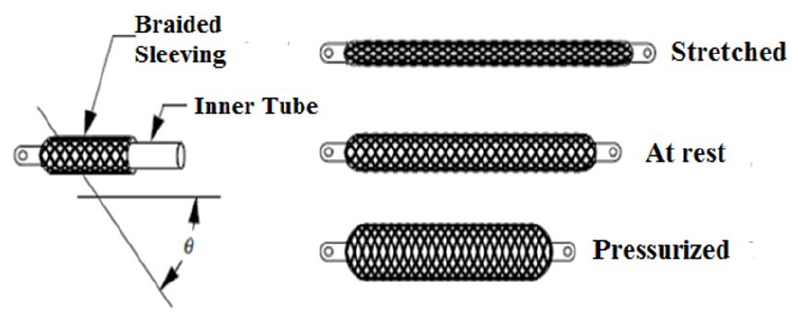
Figure 3. Braided muscle with its working [28].